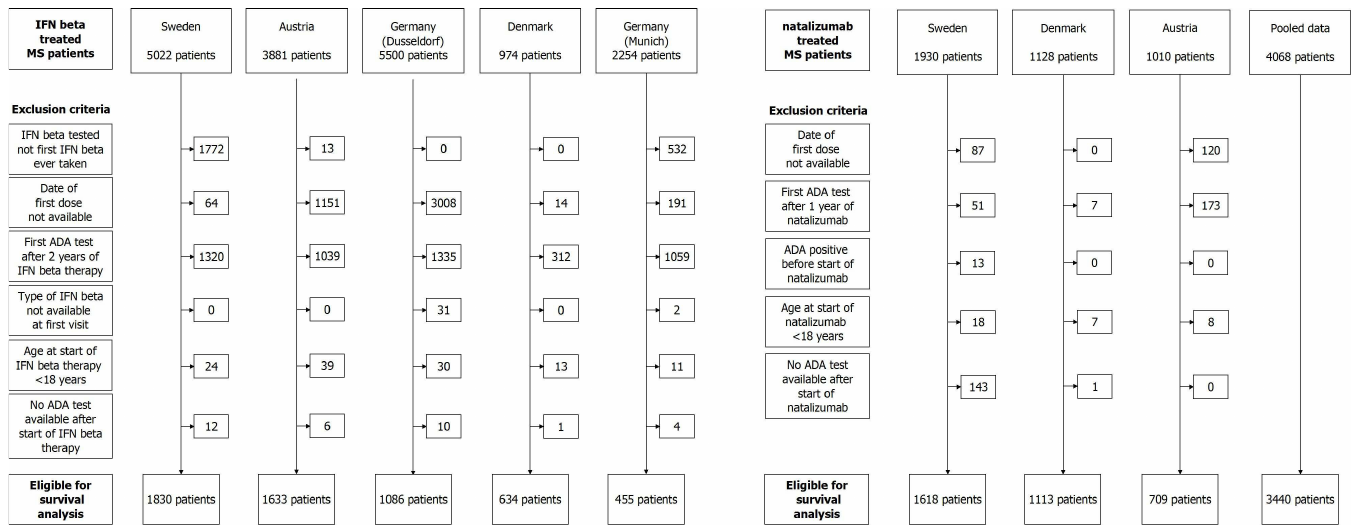
Fig 1. Inclusion flow chart. Flow chart of patients by country for IFN β (left side) and natalizumab (right side) treated patients.